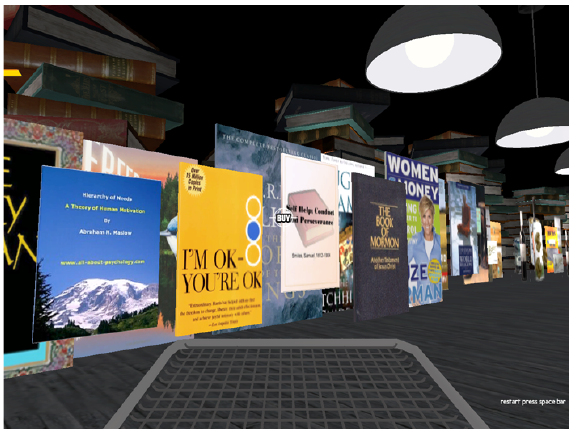
Figure 4. Still from Psychasthenia 2 website. Courtesy of the